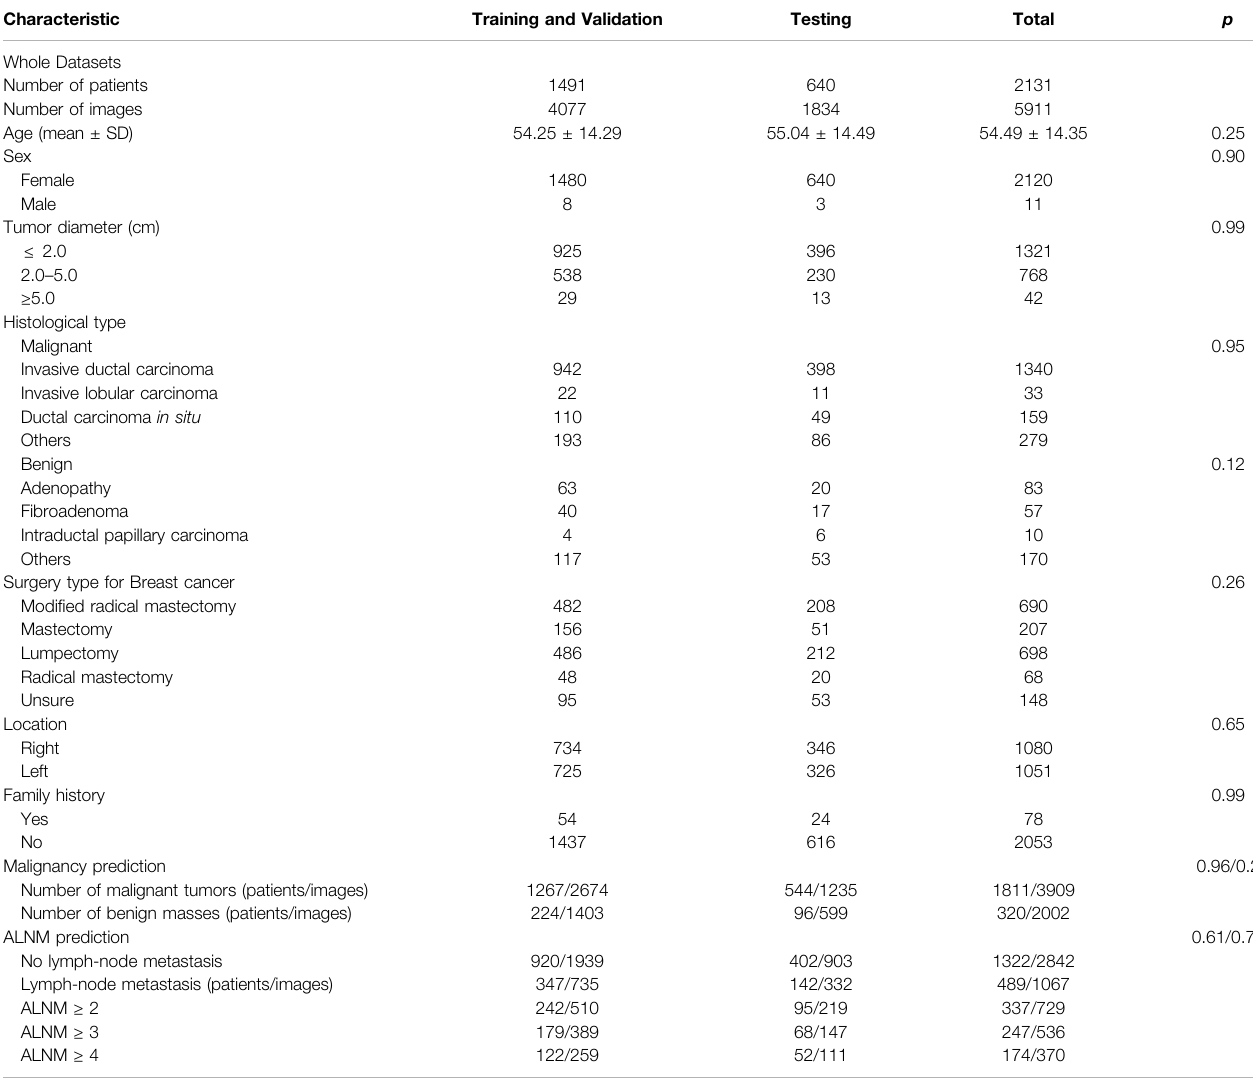
TABLE 1 | Characteristics of patients and lesions.